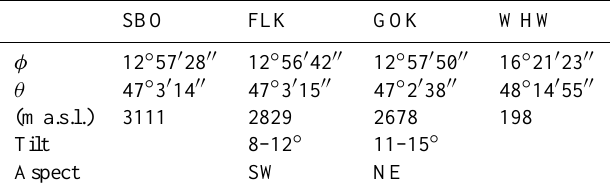
Table 1. Geographic latitude φ , longitude θ , altitude above sea level, tilts and aspects of the used measurement sites.